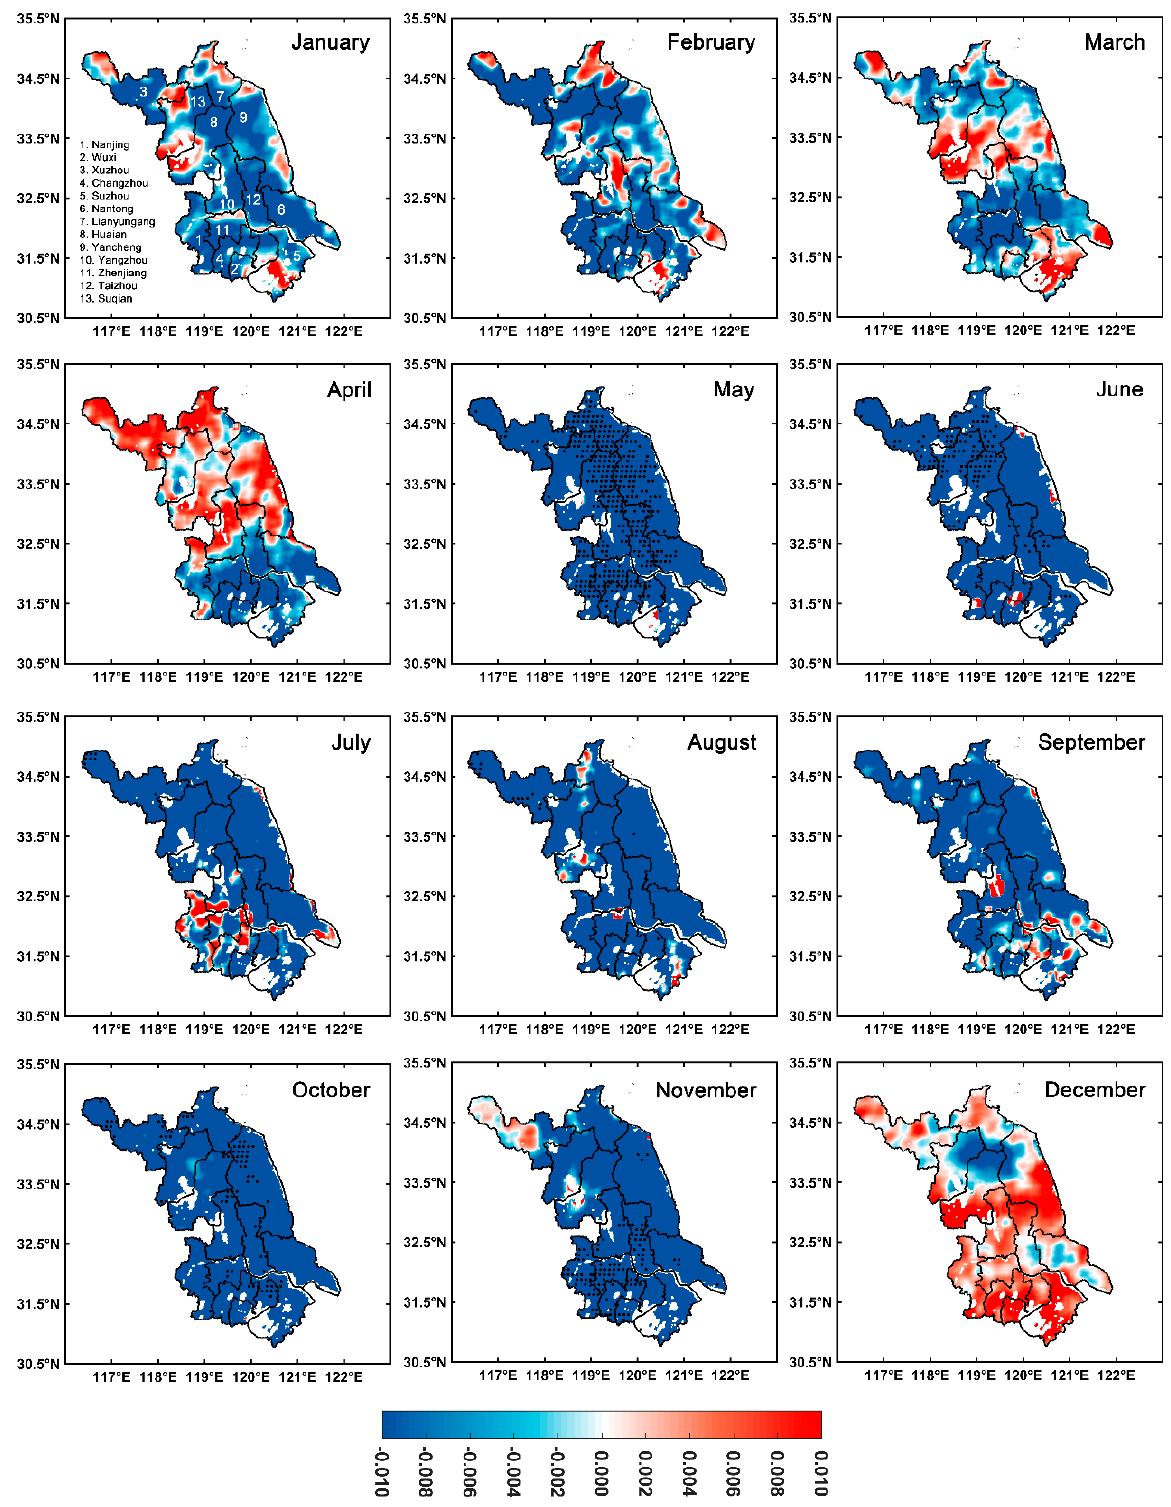
Figure 11. Monthly spatial trends of high-resolution MODIS MAIAC AOD from 2010 to 2019 in Jiangsu province. The dot (.) symbol indicates significance at 95% confidence interval.